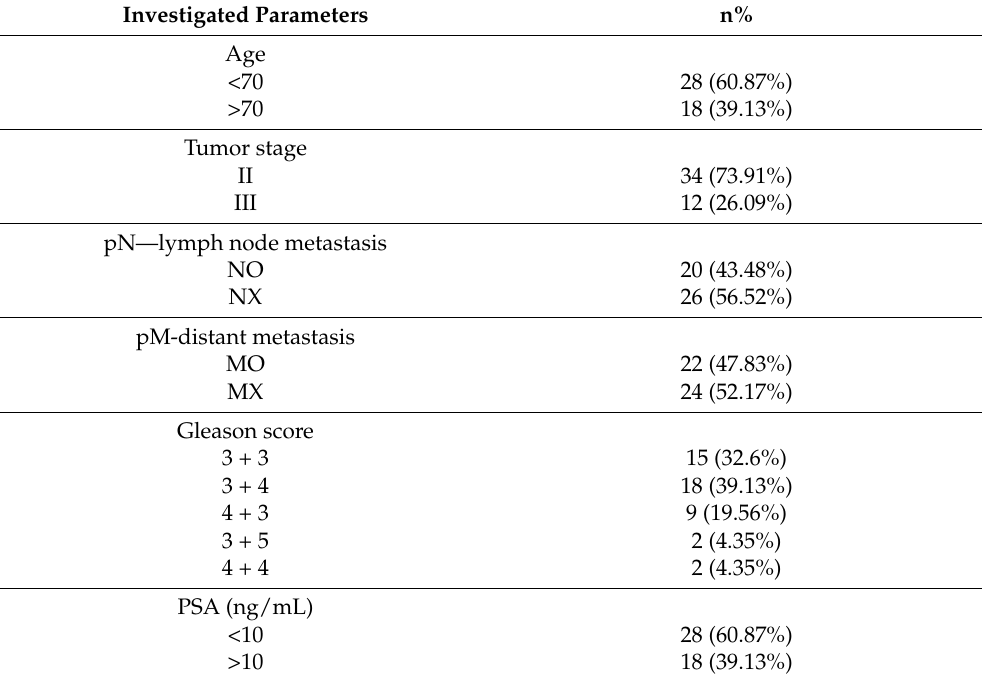
Table 1. The age and level of PSA, Gleason score, and tumor stage in investigated patients with PC. Investigated